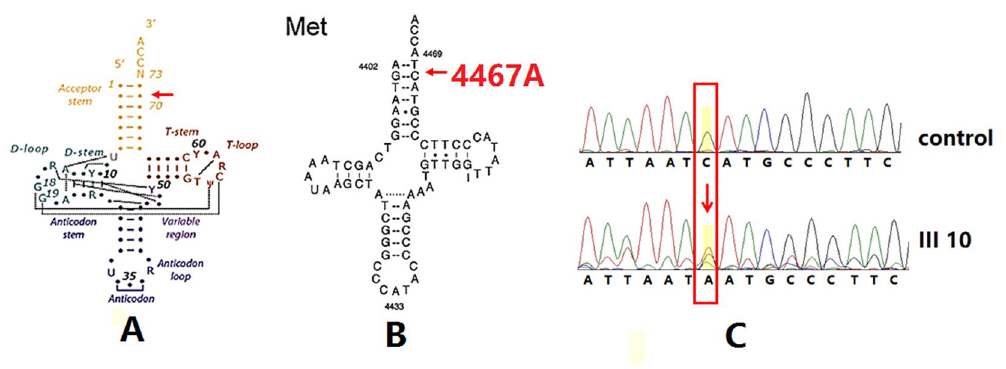
Figure 2. Identification and qualification of the 4467 C > A mutation at the 3 ′ end of the acceptor arm. ( A ) Secondary structure of tRNA: acceptor stem, D-stem, D-loop, anticodon stem, anticodon loop, T-stem, and T-loop. ( B ) The 4467 C > A mutation is located in the precursors of tRNA Met . Arrow indicates the position of the 4467 C > A mutation. ( C ) Partial sequence chromatograms including tRNA Met 4467 genes from hypertensive individual (III-10) and a married-in control